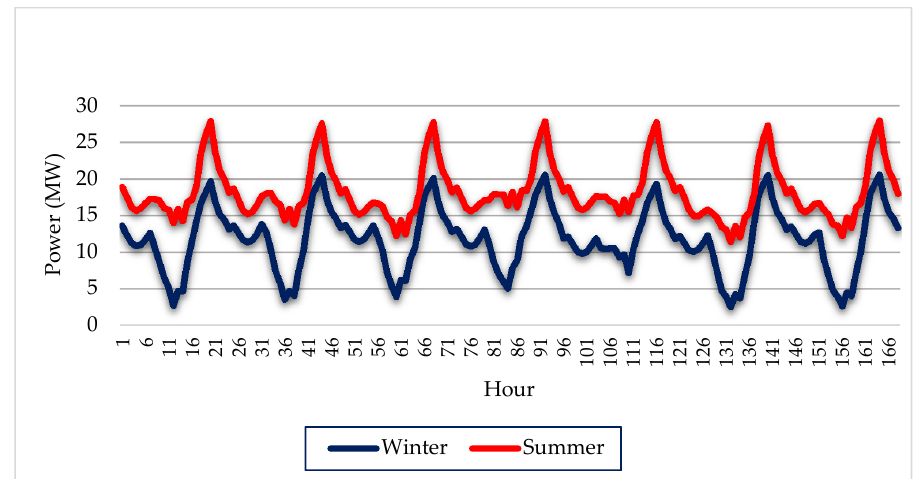
Figure 19. Residual load curve for a typical winter week versus summer week in 2030 for the RENES scenario. Source: own elaboration with the model.